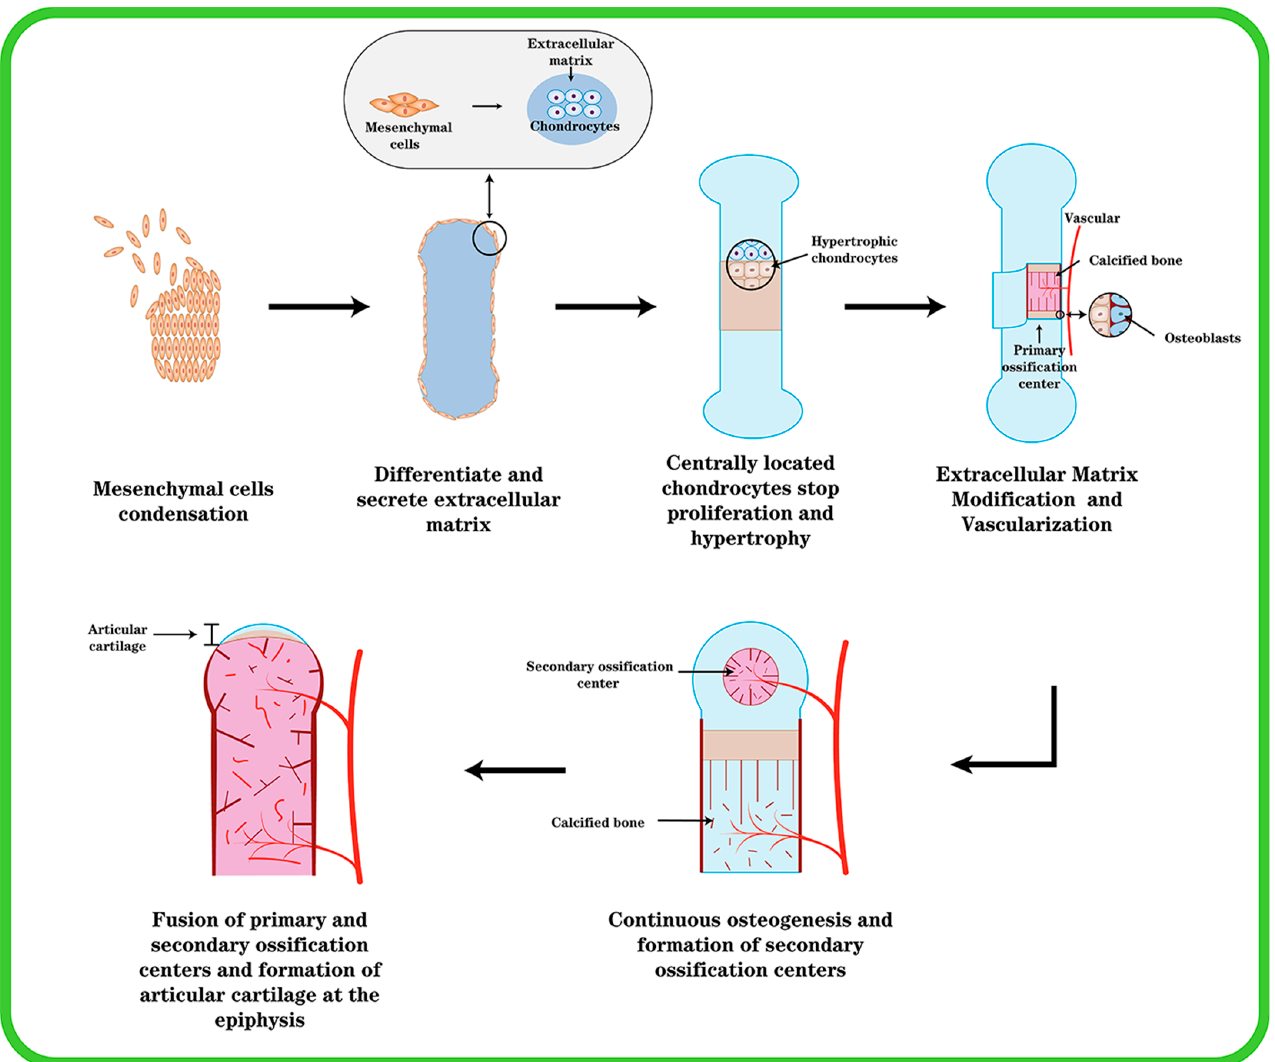
Figure 1. The formation of endochondral ossification and articular cartilage. Initially, mesenchymal cells undergo agglutination, mesenchymal cells in the center differentiate into chondrocytes and secrete type II collagen, chondrocytes continue to proliferate and secrete ECM, and cells around the agglutination express type I collagen and become cartilage membrane. The cartilage center’s cells then transform into hypertrophic chondrocytes, and blood vessels invade and create main ossification centers. Cartilage is progressively replaced by bone, and the cartilage membrane transforms into periosteum. At the ends of the elements, secondary ossification centers are created, and the epiphyseal cartilage plate is generated between the secondary and primary ossification centers. At last, the epiphyseal plate ossifies, leaving permanent articular cartilage at the element’s end.